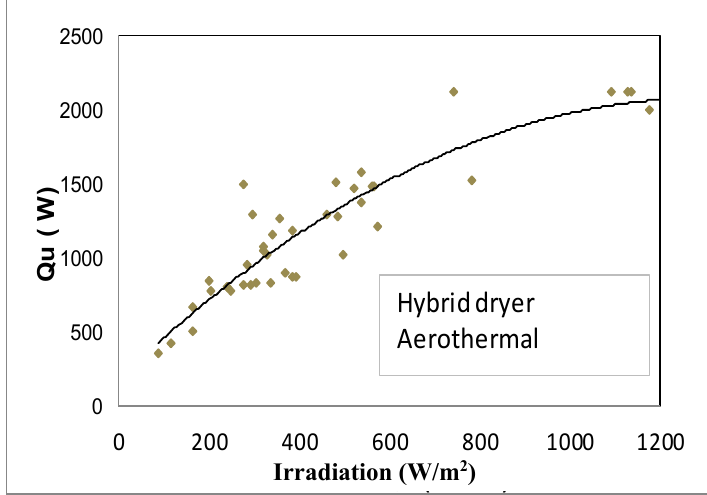
Figure 8. Heat gained in hybrid drying.